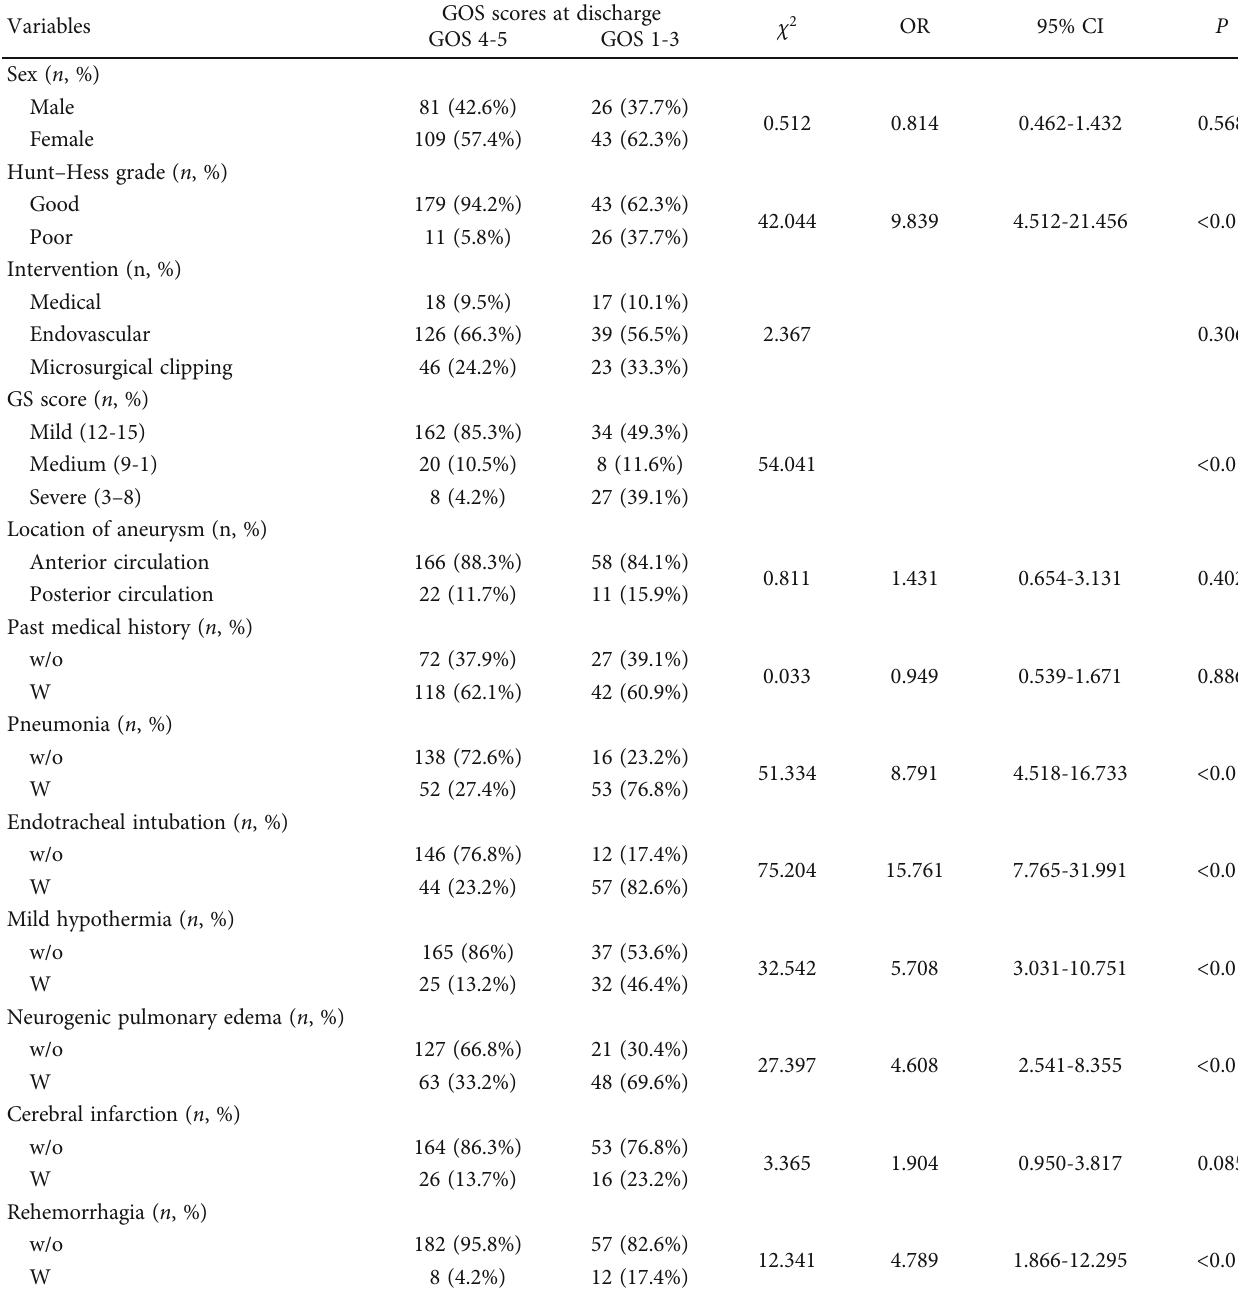
Table 1: Baseline characteristics among two GOS